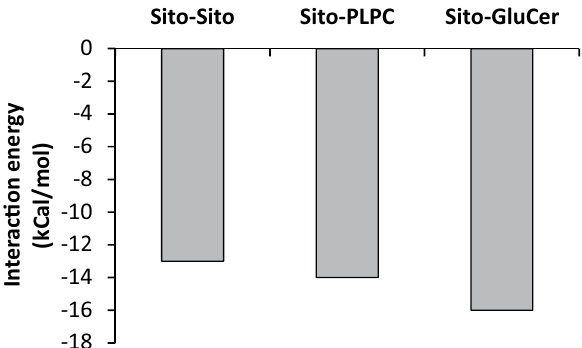
Figure 3. Interaction energy (Kcal/mol) between lipid molecules calculated from docking calculations